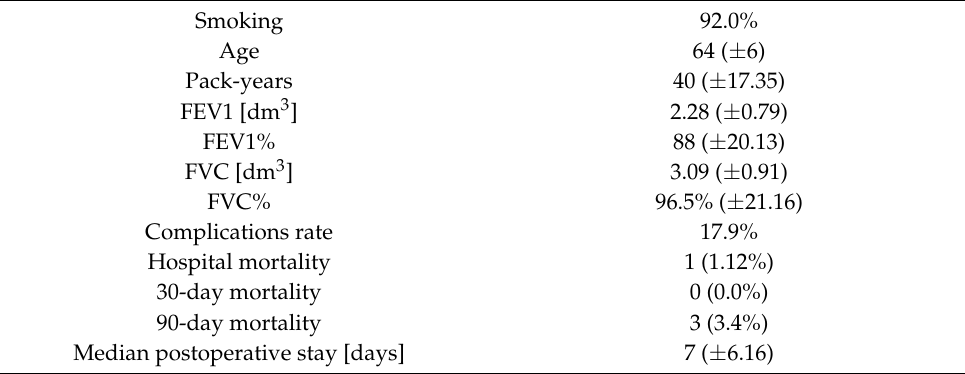
Table 1. Characteristics of patients who did not perform the 6-min walk